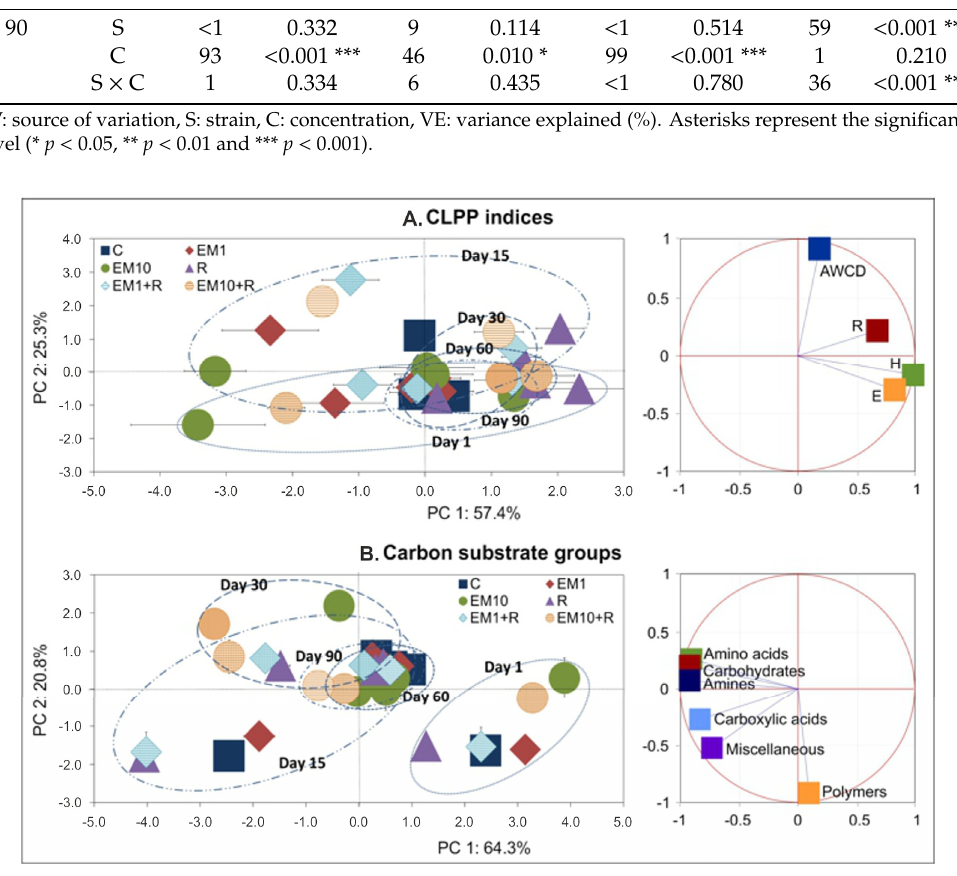
Figure 5. The PCA plots for the CLPP indices ( A ) and carbon substrate groups ( B ) generated for all the days of the experiment. The treatment abbreviations are explained in Figure 2.